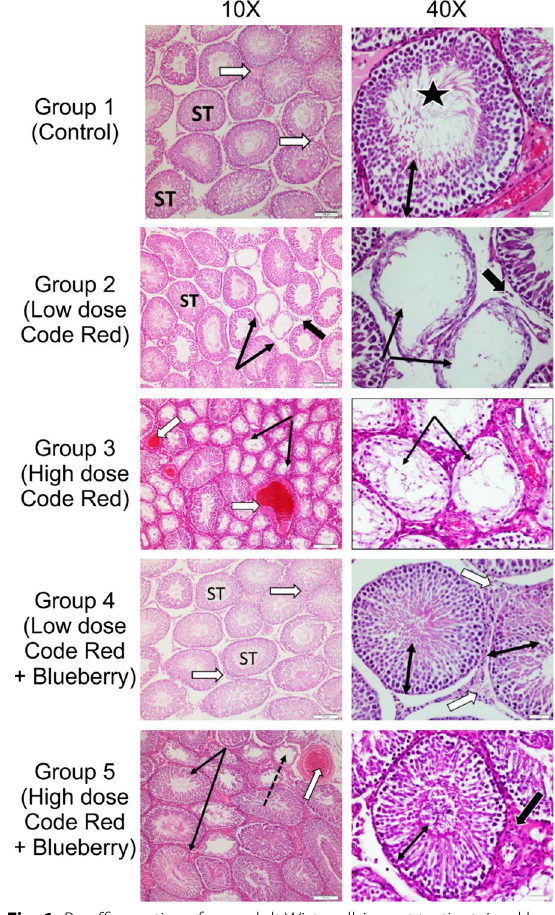
Fig. 1 Paraffin sections from adult Wistar albino rat testis stained by H&E and photographed at low and high powers ( 100 bar 200 µm × = and 400 bar 50 µm, respectively). Group 1 (Control): Normal × = control with seminiferous tubules (ST) showing regular outlines and fully‑thickened intact germ cell layers (double heads arrow) with mature sperm tails extending to the lumen (star). Interstitial cells show normal morphology (white arrows). Group 2 (Low dose Code Red): shows sporadically scattered tubules with marked degeneration and loss of germ cell layers (thin black arrows). Interstitial cells appear sparse and degenerated (thick black arrow). Group 3 (High dose Code Red): shows marked interstitial vascular congestion (white arrows), numerous tubules with degenerated germ cells (black arrows), and thickened fibrous interstitial tissue (white stars). Group 4 (Low dose Code Red Blueberry): shows marked protection against Code + Red‑induced trophic changes on spermatogenic cells. Group 5 (High dose Code Red Blueberry): shows a decrease in the degeneration + of seminiferous tubules (black arrows), with most of the tubules having near fully‑thickened germ cell layers (black arrows and double heads arrows). A few tubules show degenerated cells (dotted arrows) with nearby congested blood vessels (thick white arrow). Also, the interstitial tissue shows thickened blood vessels and degenerated cells (thick black